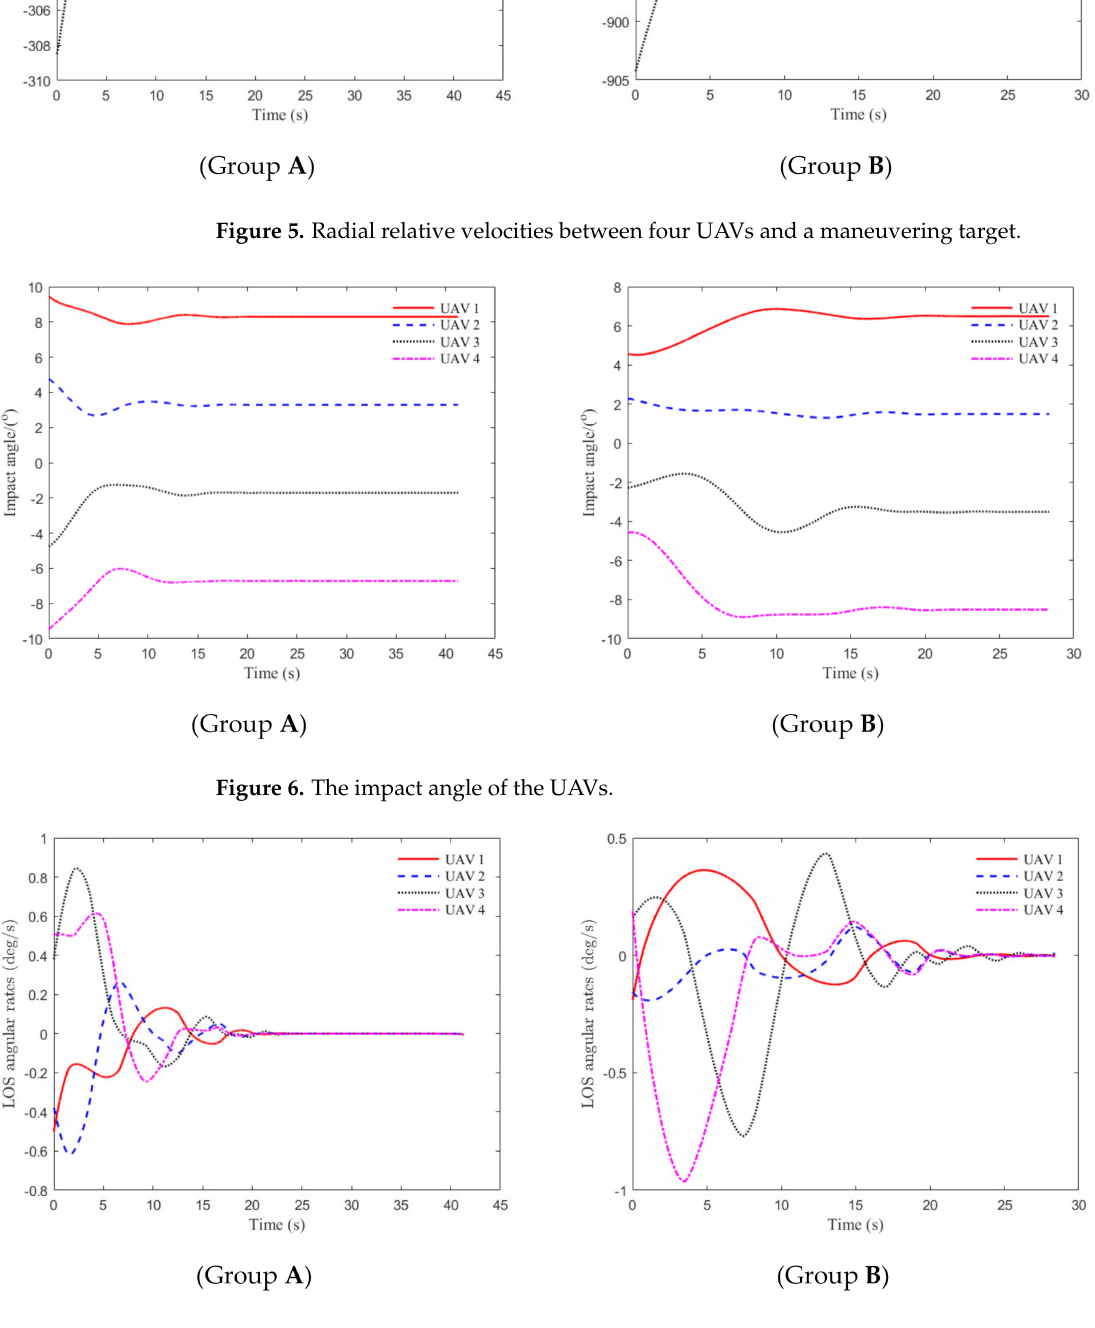
Figure 7. LOS angular rate of the